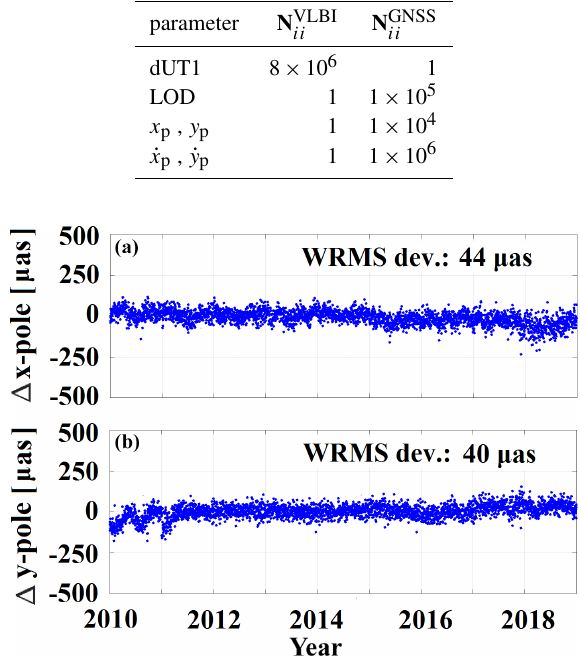
Figure 4. GNSS-only terrestrial pole offsets w.r.t. the IERS 14 C04 time